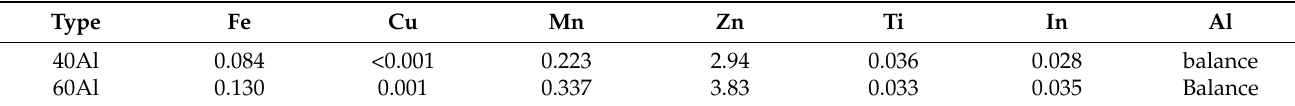
Table 2. Elemental composition of 40Al and 60Al in wt% according to